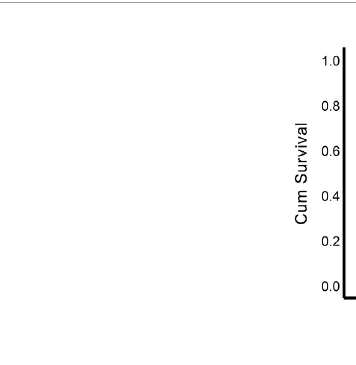
FIGURE 2 | Survival curves of the 7 cases. OS, overall survival; PFS, progression-free